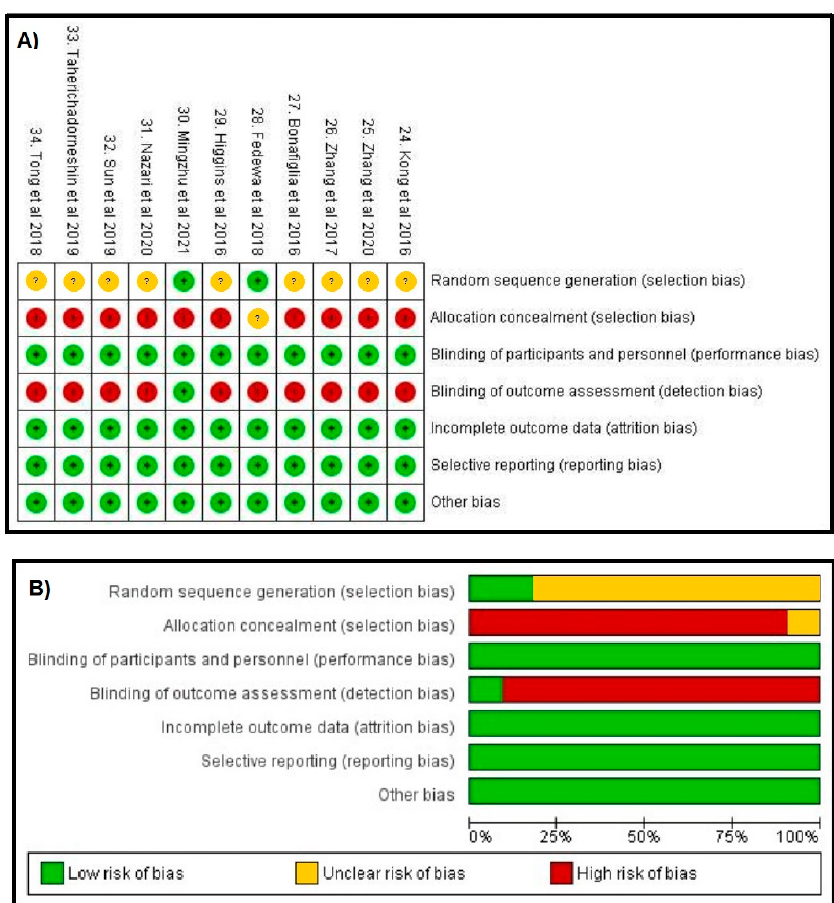
Figure 7. Risk of bias—( A ) risk of bias graph: review authors' judgements about each risk of bias item presented as percentages across all included studies; ( B ) risk of bias summary: review authors’ judgements about each risk of bias item for each included